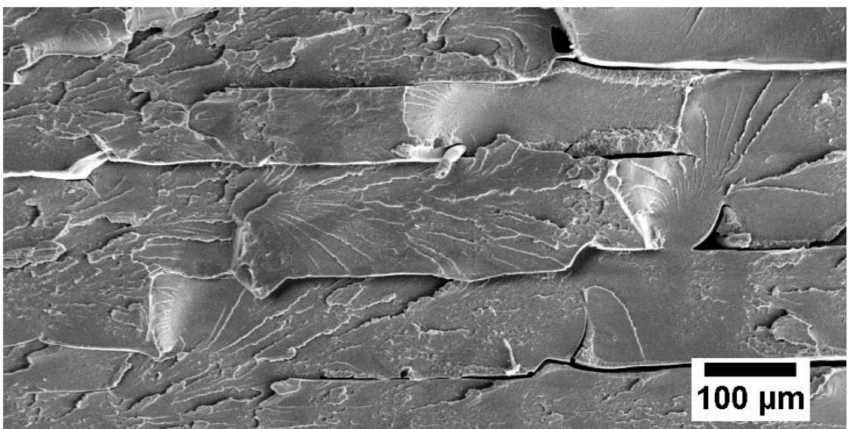
Figure 3. Scanning emission microscopic image on fracture surface of MWCNT/PEEK nanocompos- ites with 3 wt.% MWCNT loading (Reproduced with permission from m. F. Arif, H. Alhashmi, K.